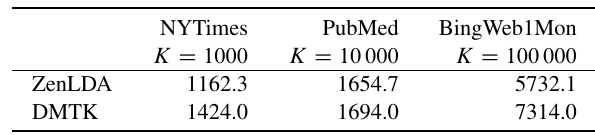
Table 4 Comparison between ZenLDA and DMTK: total training time in 100 iterations on NYTimes/PubMed and 60 iterations on